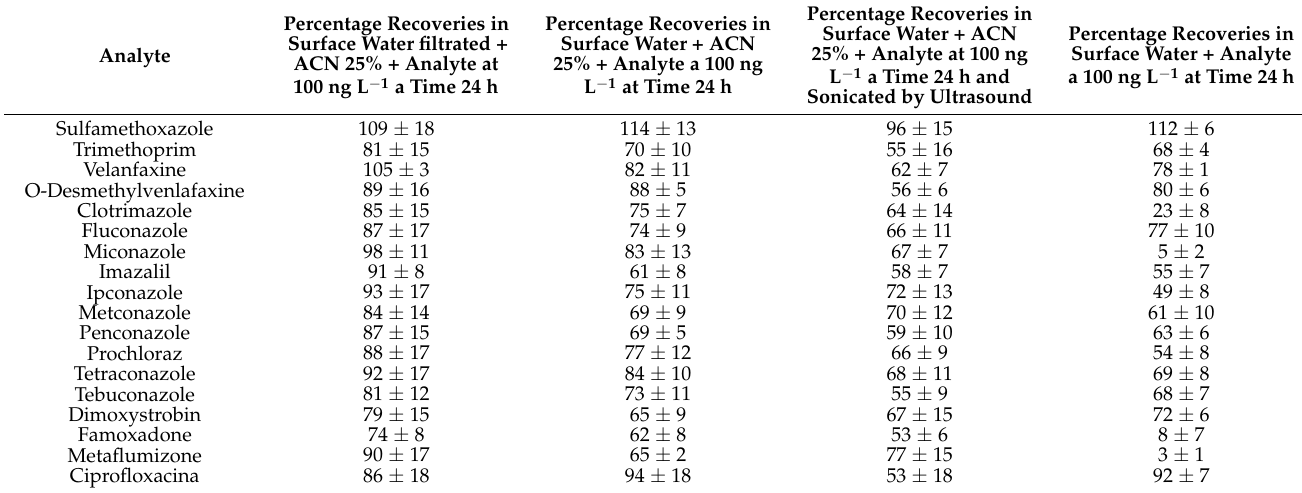
Table 6. Percentage recovery of analyte at 100 ng L − 1 after 24 h in: Surface Water filtrated + ACN 25%, Surface Water + ACN 25%, Surface Water + ACN 25% and sonicated by ultrasound and Surface Water.